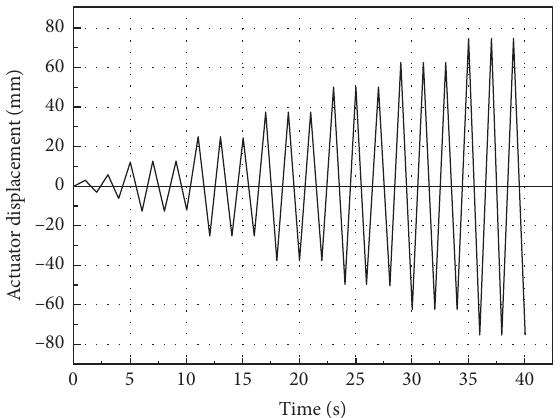
Figure 9: The increasing lateral